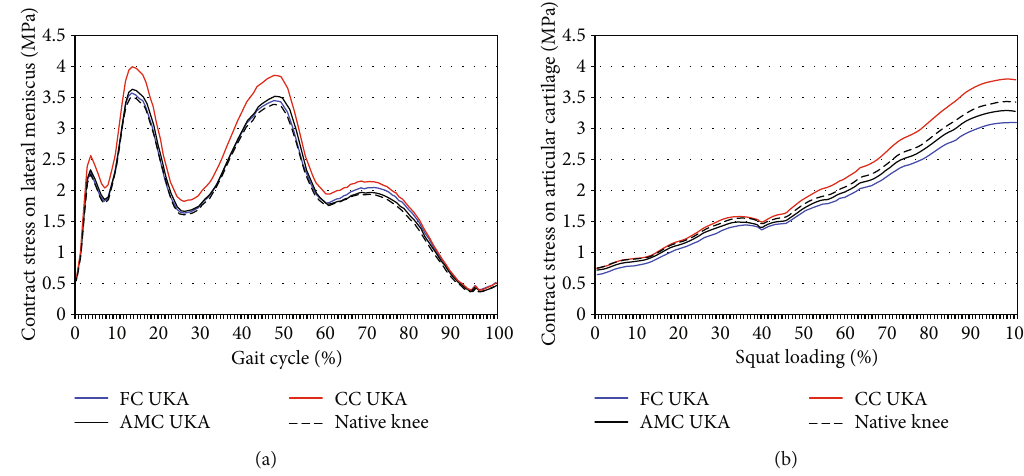
Figure 6: Comparison of the contact stress on the articular cartilage in three customized UKA designs with three di ff erent conformities against that on a native knee under (a) gait and (b) squat loading